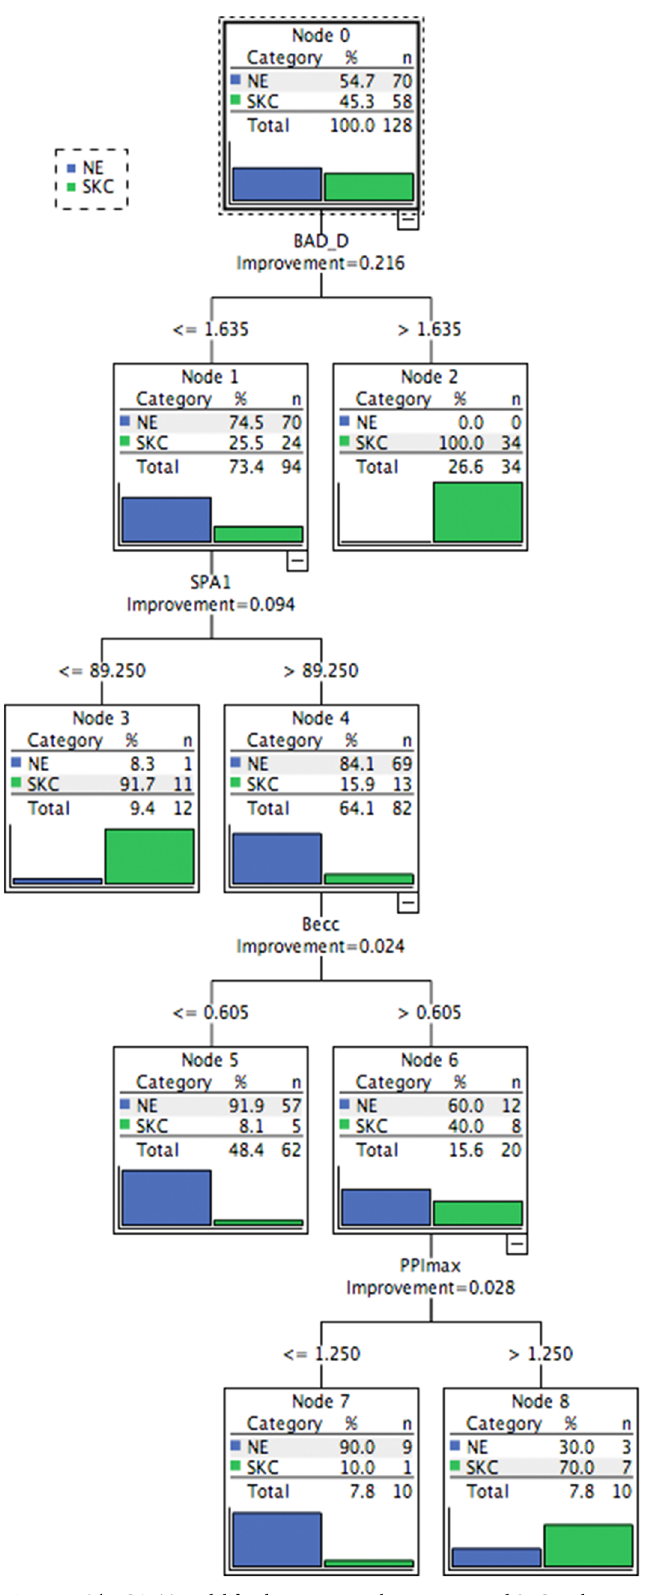
Figure 2. The CART model for discriminating between NE and SKC in the training database. This discriminating rule achieved 89.7% sensitivity and 94.3% specificity. When generating a split, the following cutoff values were obtained: